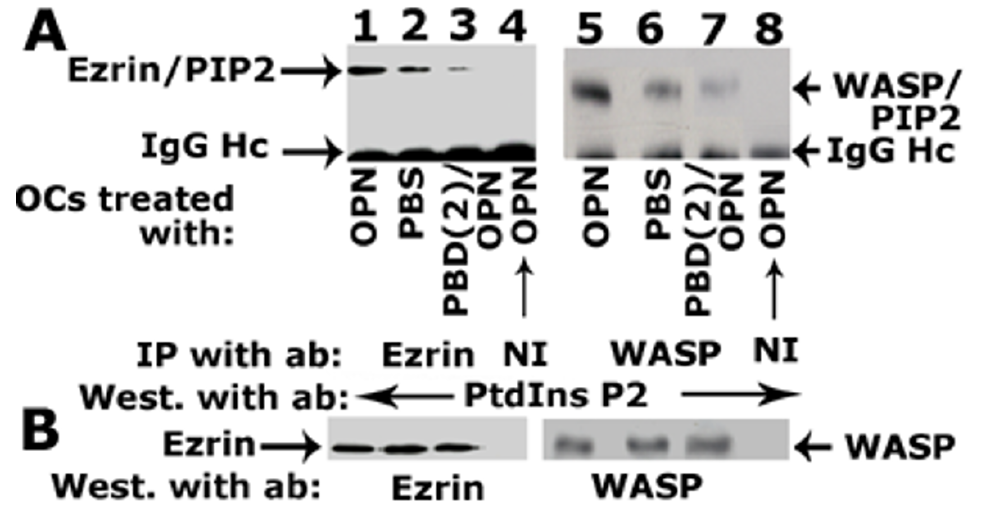
Figure 11 Transduction of PBD containing gelsolin peptides reduces the association of phosphoinositides WASP and Ezrin proteins Panel A: Western analysis with an antibody to PtdIns P2. Osteoclasts were treated as indicated in the figure. The lysates were immunoprecipitated with either ezrin (lanes 1–3) or WASP (lanes 5–7). Immunoprecipitation with non- immune serum is shown in lanes 4 and 8. Arrows point to IgG HC as well as PtdIns P2 (PIP2) associated ezrin and WASP pro- teins. Panel B: Western analysis with an antibody to ezrin or WASP. Arrows indicate ezrin and WASP proteins. The results represent one of three experiments